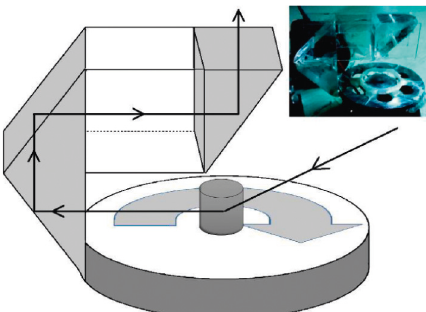
Figure 3: Different ways we could make and develop the scattering spectrophotometer